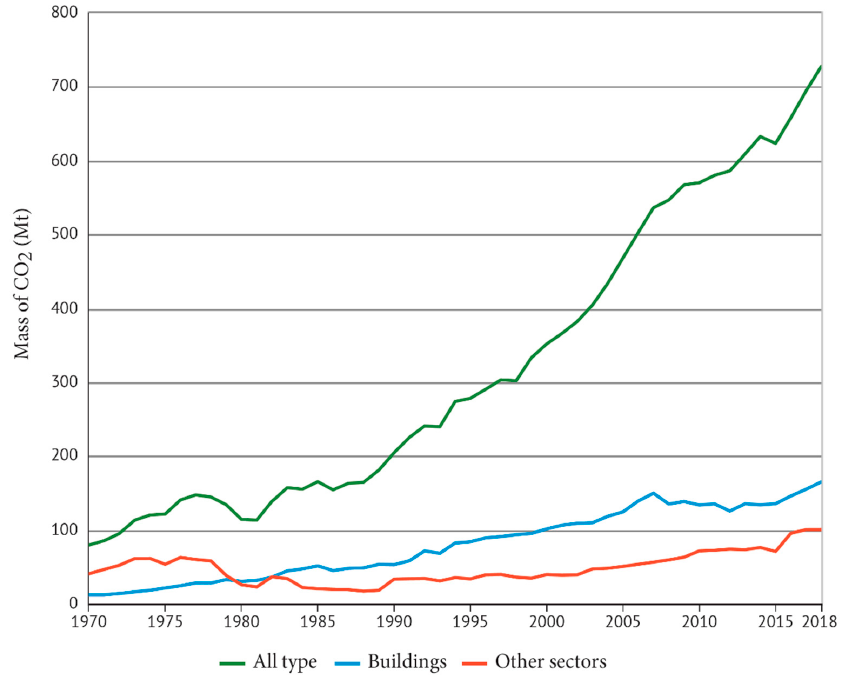
Figure 3. Sectorial CO 2 emissions in Iran from 1971 to 2018, modified from [63].